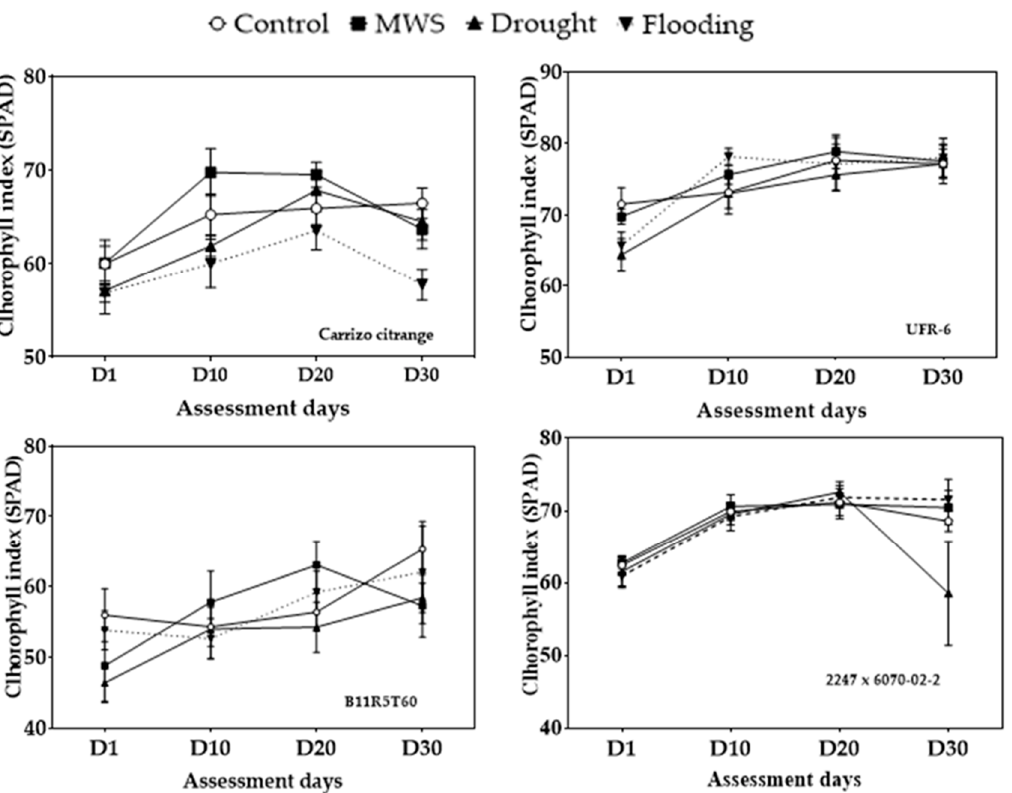
Figure 1. Time course for mean chlorophyll index (SPAD) values ± standard error (SE) with four water treatments (Control, MWS, Drought, and Flooding) on four citrus rootstocks (Carrizo citrange, UFR-6, B11R5T60, and 2247 x 6070-02-2) during 30 days of assessment. MWS: Medium Water Stress.